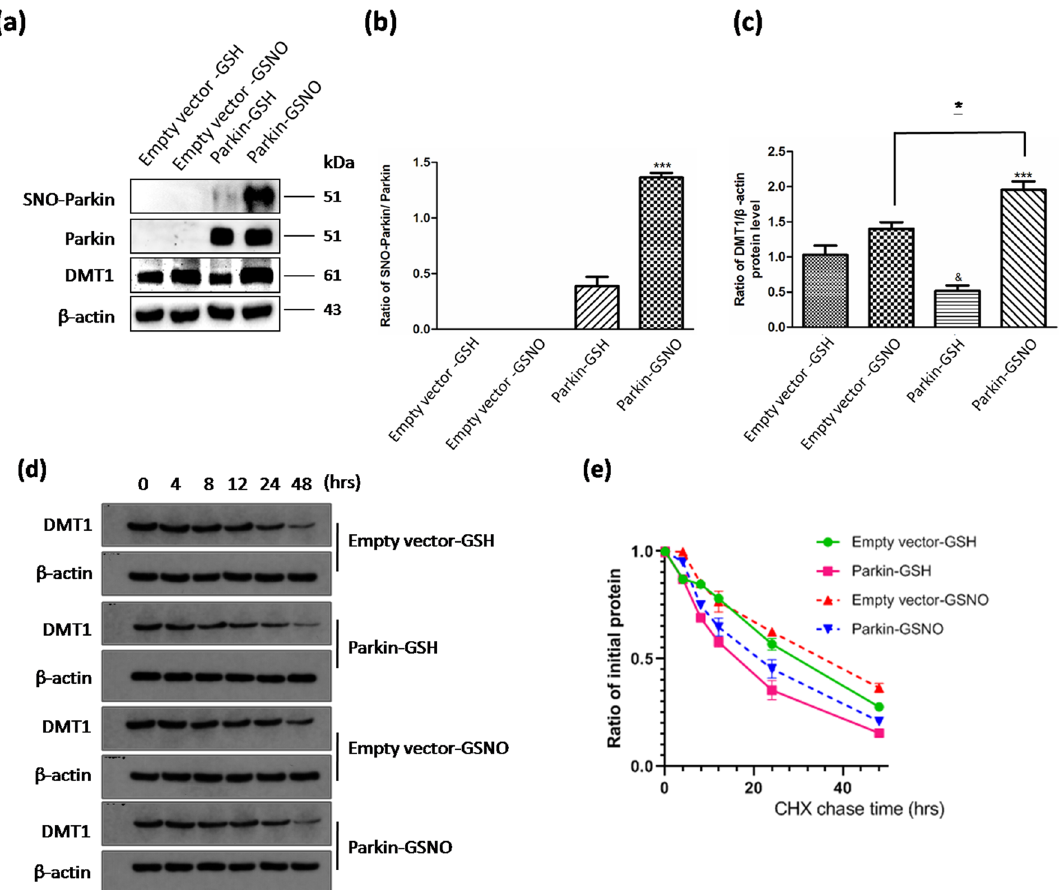
Figure 2. Effect of GSNO on DMT1 levels in parkin-overexpressing SH-SY5Y cells. ( a ) Changes of SNO- parkin and DMT1 protein levels in SH-SY5Y cells transiently expressing parkin with 200 μM of GSNO or GSH treatment for 24 h. ( b ) Statistical analysis of changes in SNO-parkin levels. Data were presented as the ratio of SNO-parkin/parkin. *** P = 0.0002, parkin-GSNO versus parkin-GSH. ( c ) Statistical analysis of changes in DMT1 levels. Data were presented as the ratio of DMT1/β-actin. & P = 0.013, parkin-GSH versus empty vector- GSH; *** P = 0.0003, parkin-GSNO versus parkin-GSH; * P = 0.025, parkin-GSNO versus empty vector-GSNO. N = 9. ( d ) DMT1 protein half-life (t1/2) was determined by pulse-chase assay and immunoblotting. CHX was administered in SH-SY5Y cells with different treatment to block protein synthesis. ( e ) Statistical analysis of DMT1 protein half-life (t1/2). P = 0.027, parkin-GSH versus empty vector-GSH; P = 0.034, parkin-GSNO versus empty vector-GSNO; P = 0.121, empty vector-GSNO versus empty vector-GSH; P = 0.074, parkin-GSNO versus parkin-GSH. N =